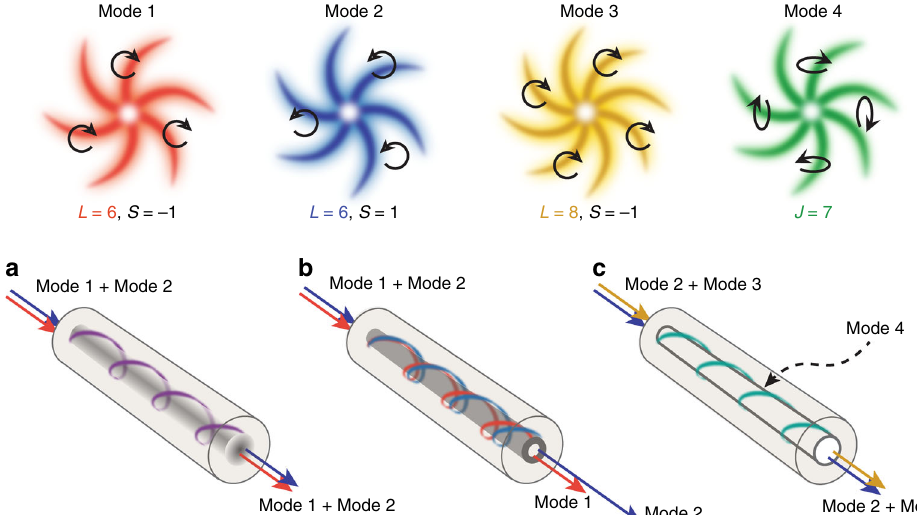
Fig. 1 Three regimes of spin orbit interaction. Conceptual illustration of the effect of SOI, with OAM depicted as a spiral (with handedness giving sign, and the number of arms the value of L ) and SAM as circular black arrows. Colors are used to distinguish different modes and do not indicate the frequency of the light beam. a In the scalar approximation (negligible SOI), two OAM states of the same | L | will propagate with the same effective index, regardless of polarization. b In fi ber engineered for OAM-based data transmission, due to SOI, states with OAM and SAM parallel and antiparallel have different effective and group indices. c In strongly-SOI-enhanced fi bers, superpositions of free space SAM and OAM states with speci fi c relative amplitudes and phases propagate through the fi ber as a single mode. These modes are de fi ned by a total AM and can be obtained as the product of a given OAM phase distribution and a space-variant elliptical polarization state (as in mode 4), but they are neither OAM nor SAM eigenstates, and would not be propagation-